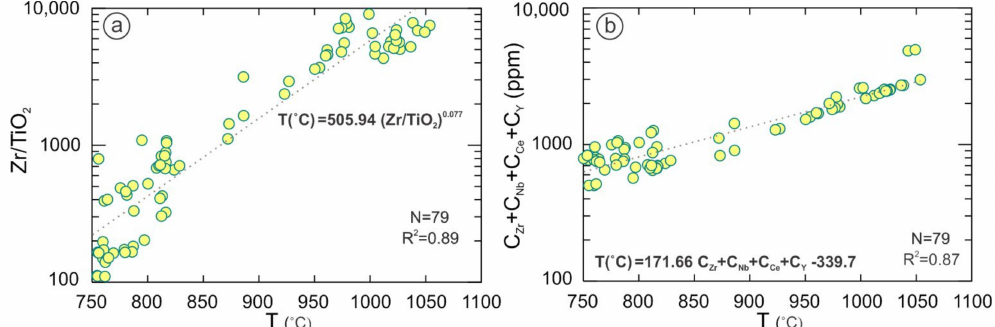
Figure 5. HFSE- based parameters ( a ) Zr/TiO 2 and ( b ) C Zr + C Nb + C Ce + C Y versus T ( ◦ C) with a strong correlation with temperature in peralkaline and alkaline rocks (n = 79 peralkaline to alkaline rocks with M > 2, and SiO 2 > 45wt.%, http://georoc.mpch-mainz.gwdg.de/georoc/, accessed on 29 August